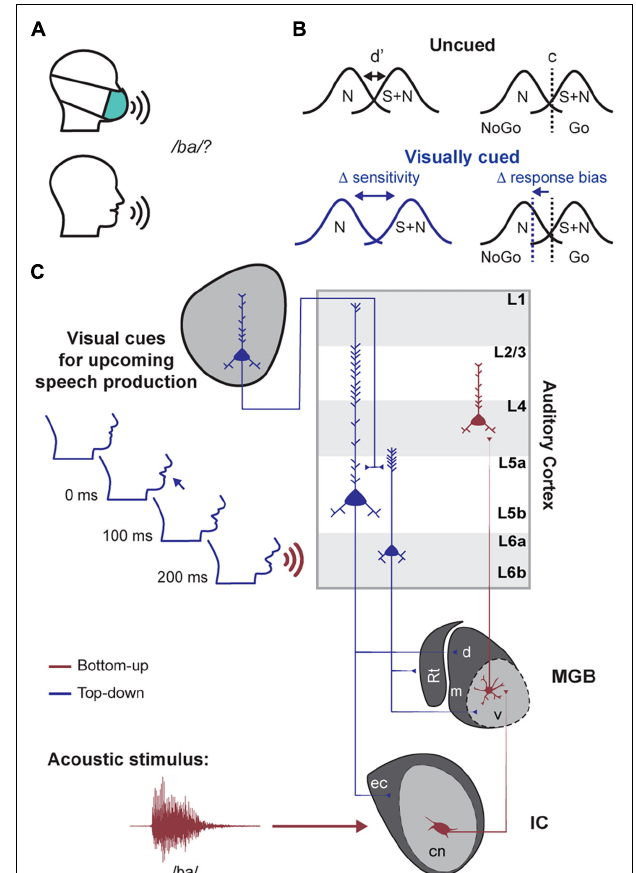
FIGURE 1 | A proposed role for descending projections in predictive listening tasks. (A) A basic consonant recognition task is easier in the presence of visual speech cues (e.g., mouth movements). (B) Hypothesized changes in signal detection theory metrics between visually cued and uncued conditions. N = noise distribution; S + N = signal and noise response distribution. D-prime (d (cid:48) ) and c refer to the sensitivity and criterion terms, respectively. (C) Schematized circuit diagram for one way that cross-modal inputs elicited by facial movement could activate auditory corticofugal neurons for enhanced processing of expected speech cues. Top-down descending auditory corticofugal projections to the inferior colliculus (IC) and medial geniculate body (MGB) are illustrated in blue. Bottom-up corticopetal pathways are illustrated in red. Rt = thalamic reticular nucleus; cn/ec = central nucleus and external cortex of the IC; m/d/v = medial, dorsal and ventral subdivisions of the